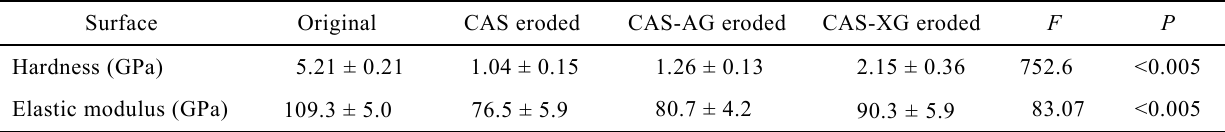
Table 1 Nanoindentation hardness and elastic modulus of enamel surfaces subjected to different erosion treatments and one-way ANOVA result.